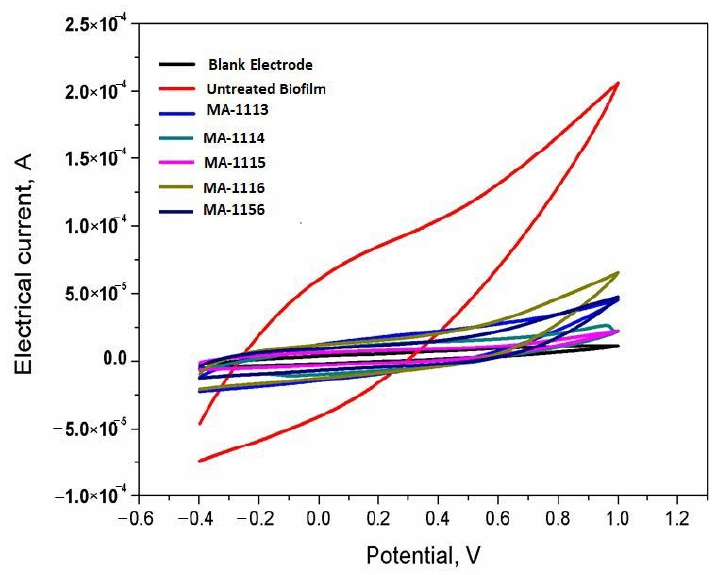
Figure 7. Bioelectrochemical responses of untreated vs. treated S. aureus biofilms with one concentration of each fluoroarylbichalcophenes.